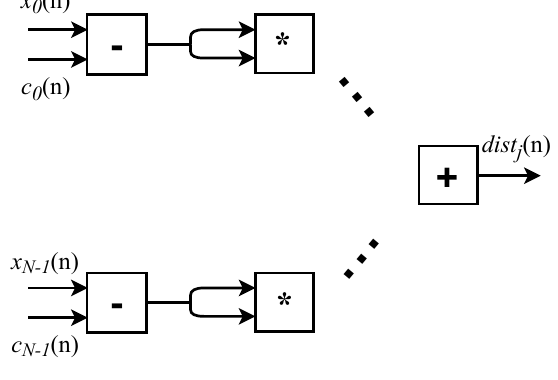
Figure 2. Distance